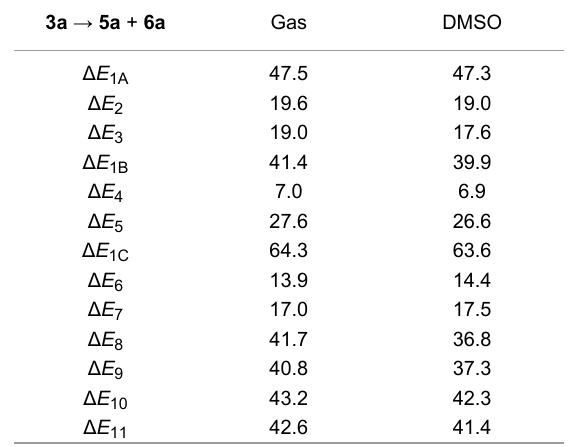
Table 3: Electronic energy barriers in kcal·mol –1 for the conversions of acetal fulvene 3a into indenes 5a and 6a calculated at the B3LYP/6- 31+G** theoretical level.